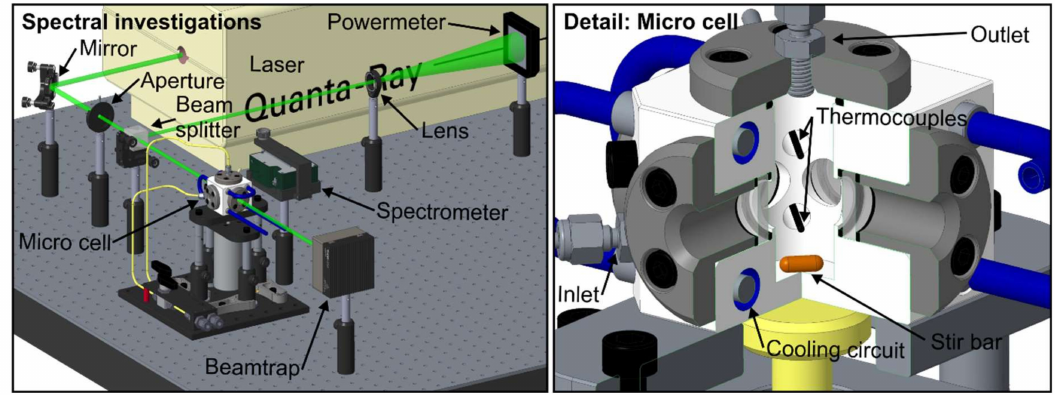
Figure 1. Optical setup ( left ) and internal design (sectional view) of the micro cell ( right